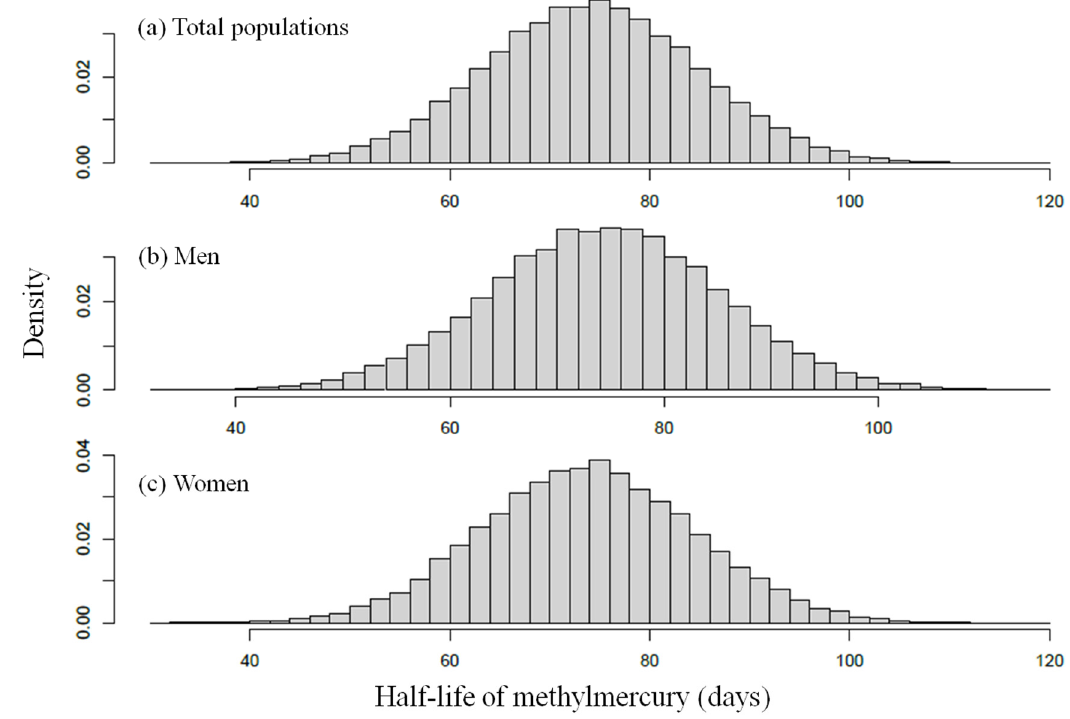
Figure 2. Population distribution for methylmercury half-life (years); posterior distribution for ( a ) total populations, ( b ) men, and ( c )